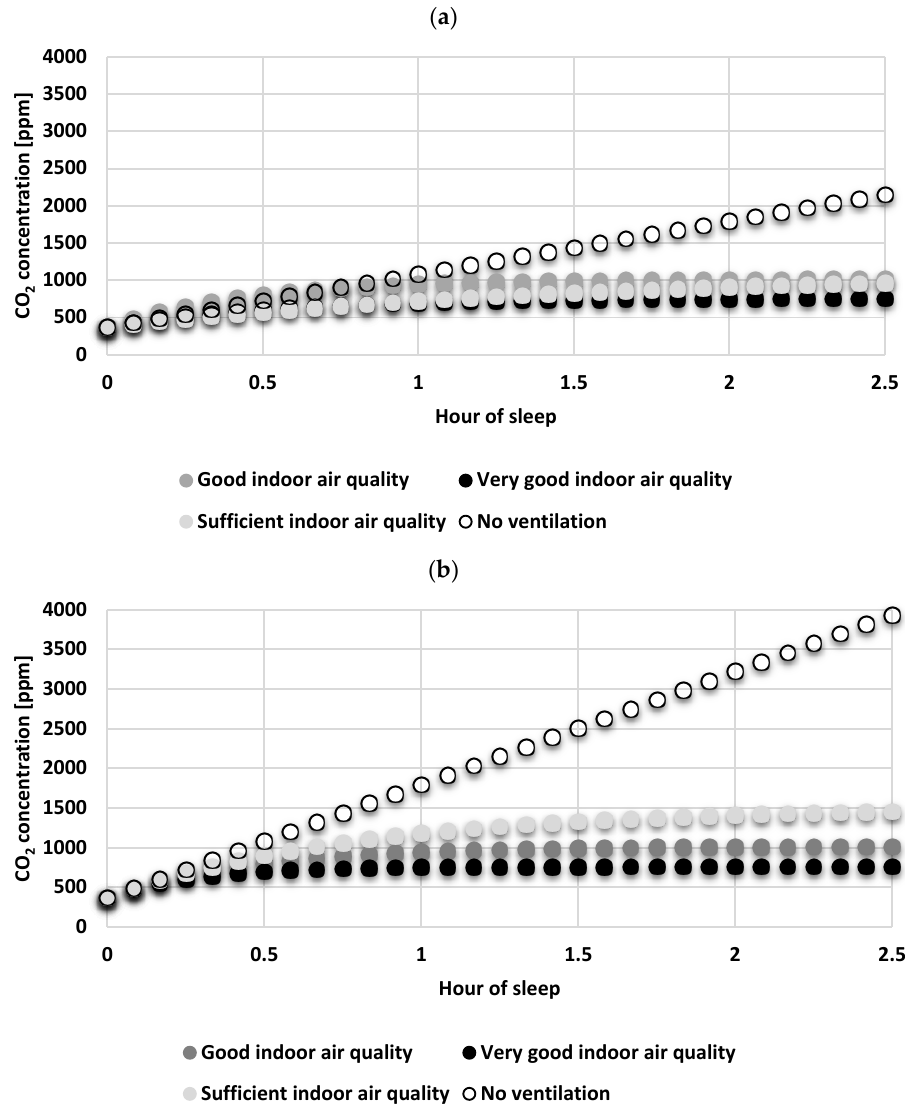
Figure 5. Assumed number of children during operation of the fans over eight months, ( a ) for five children in the room, ( b ) for 10 children in the room